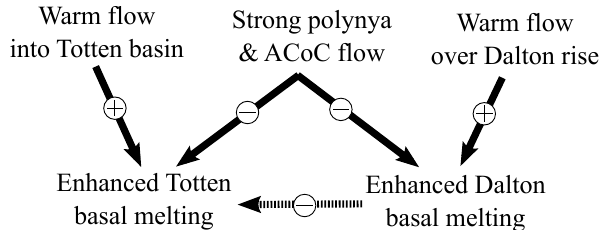
Fig. 7. The interaction between the Totten and Dalton ice shelves, the Dalton ice tongue polynya and on shelf flow is summarised. A negative interaction is shown by (cid:9) , while a positive interaction is shown by ⊕ . Strong polynya and ACoC flow has a negative impact on warm water supply to both ice shelves, while warm water flow into the Totten basin and over the Dalton rise has a positive impact on basal melting of the Totten and Dalton ice shelves, respectively. Increased basal melting of the Dalton ice shelf can have a strong negative affect on the Totten ice shelf. The dependence of this last interaction on strong ACoC flow is shown by the dashed